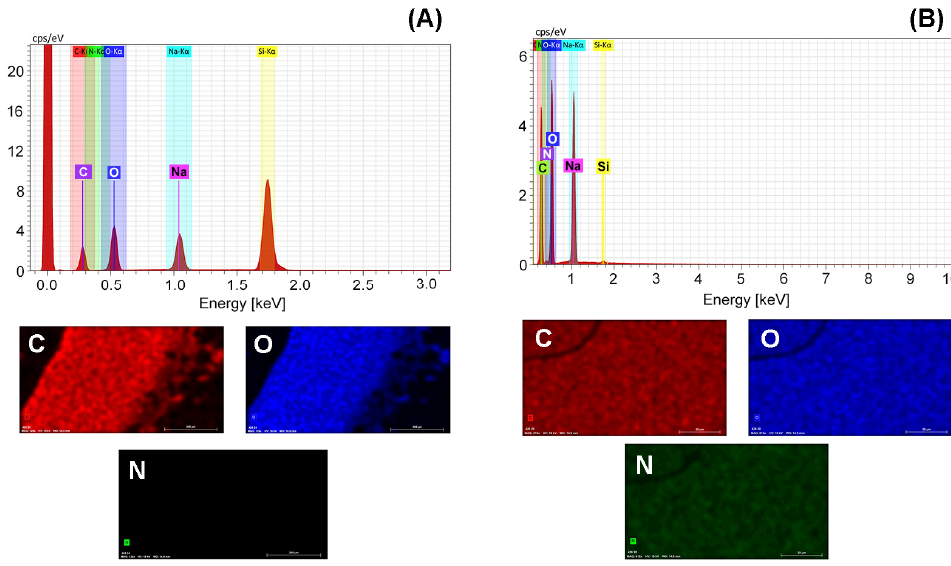
Figure 2. EDX spectra of ( A ) CQD@Blank and ( B ) CQD@Leu. Table 2. Elemental (EDX) analysis of the selected CQDs for the C, O, N elements detection. Mass Weight/%